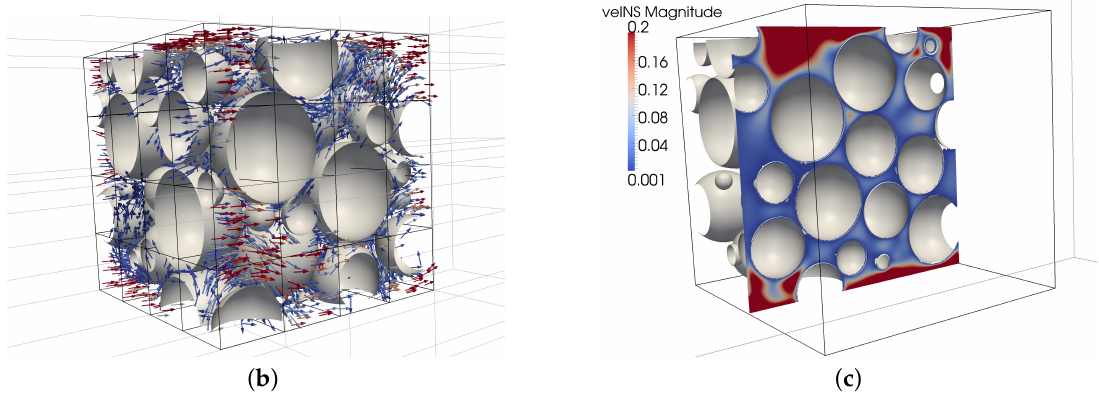
Figure 12. Visualization of the flow field of the channel flow with porous structure. ( a ) Flow field of the whole computational domain; ( b ) Flow field inside the porous structure; ( c ) Cut through the velocity field at y = 8.0 in porous structure. velNS Magnitude corresponds to the magnitude of the velocity in NS